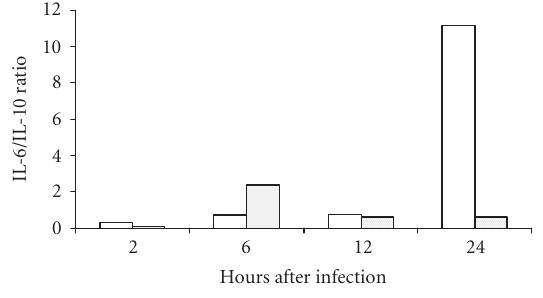
Figure 2: IL-6/IL-10 ratio in BALB/c mice protected with anti-LPS MAb Ru-O1 (gray bars) and unprotected mice (white bars) after the IP infection with 50 CFU of K pneumoniae Caroli (O1 : K2) at di ff erent time points.